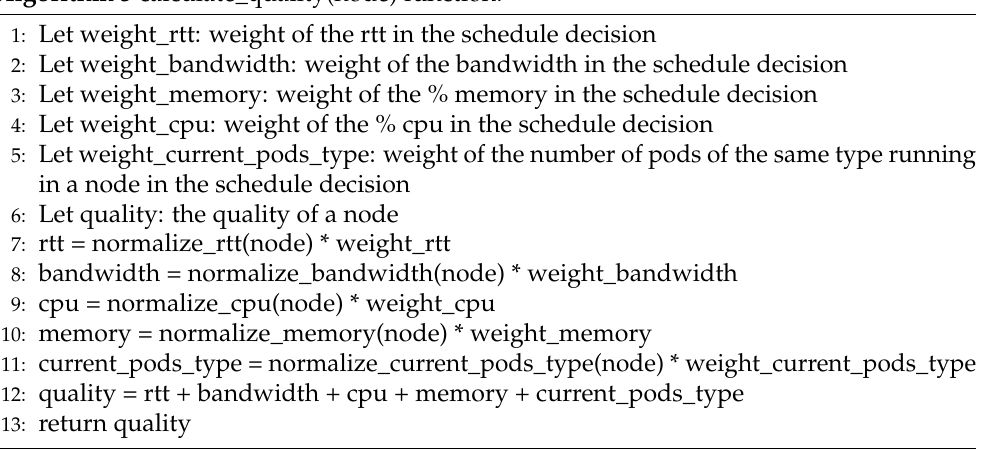
Algorithm 3 calculate_quality(node) function.